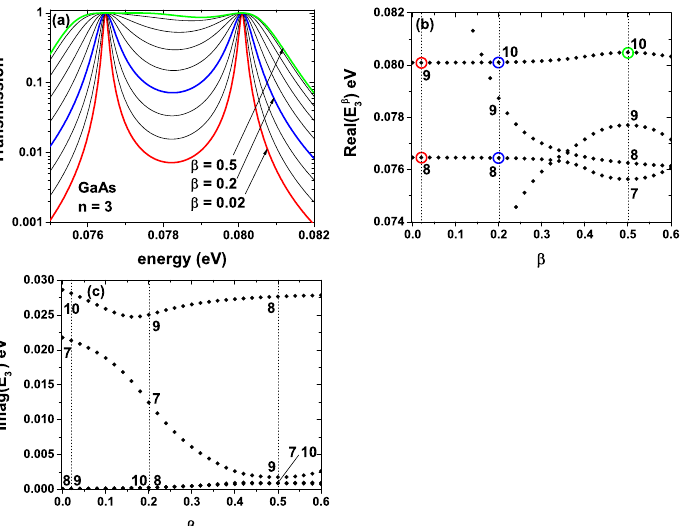
Figure 5. In ( a ), transmission probability for the GaAs-Al 0.3 Ga 0.7 As lattice for n = 3 as a function of the electron energy for different values of the β -parameter. In ( b , c ), lattice eigenvalues real and imaginary parts E β , respectively, as a function of the β n , i